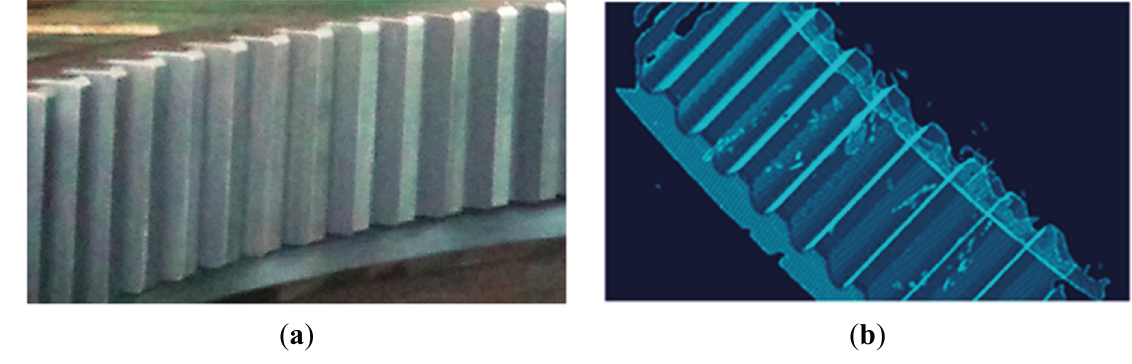
Figure 13. ( a ) A large-scale gear rim; ( b ) The original